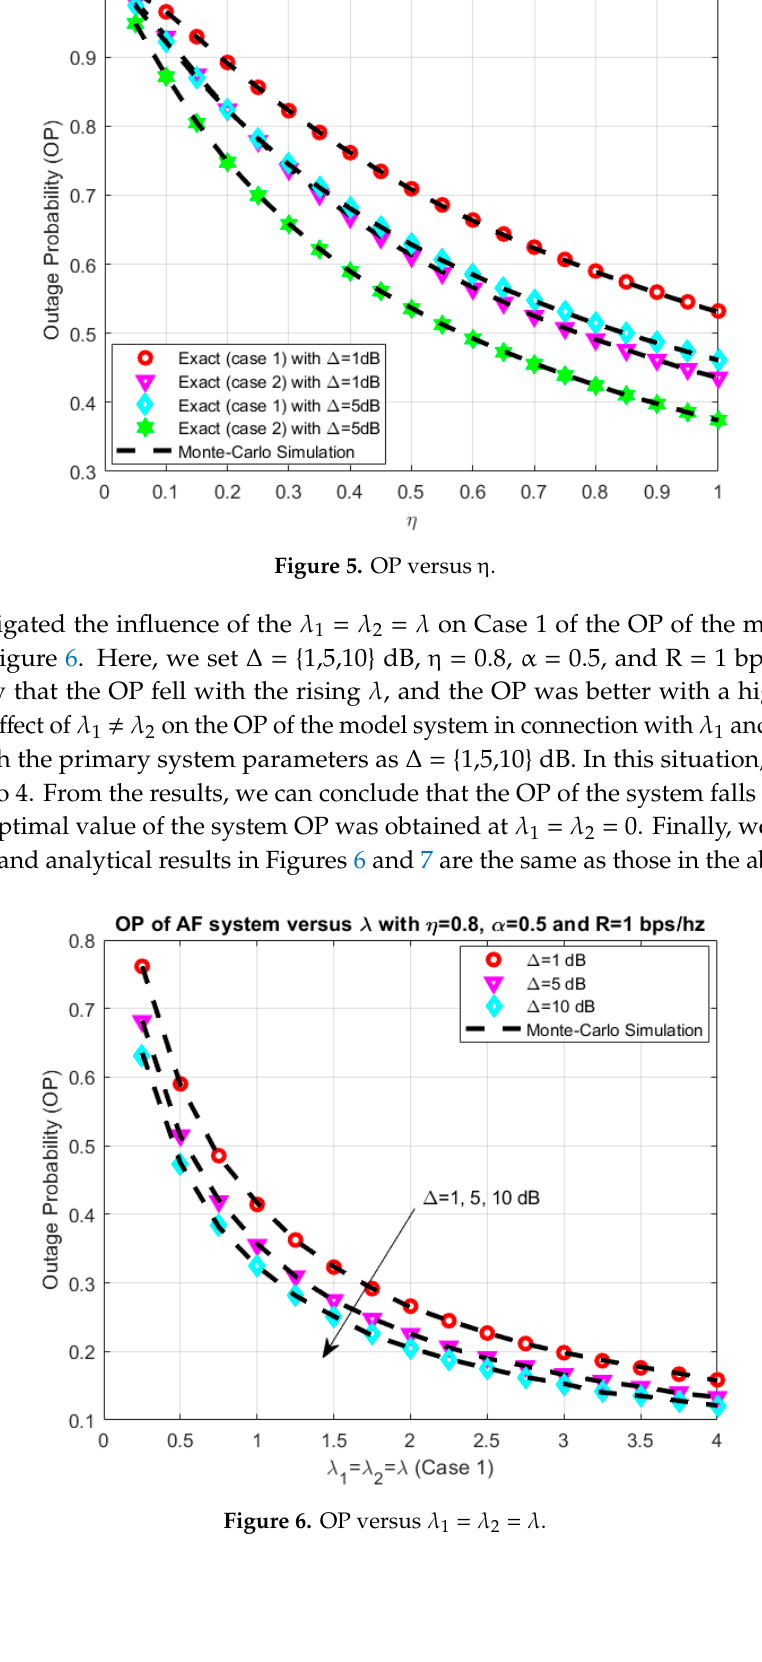
Figure 7. OP versus λ 1 ≠ λ 2 . Notably, the EE of the model system versus α is shown in Figure 8 with η = {0.5, 0.85}, R = 1 bps/Hz, Δ = 5 dB, and α varying from 0 to 1. From Figure 8, we can conclude that the EE rises significantly when α rises from 0 to 0.5, after which the EE value decreases. The optimal value of EE could be obtained with α from 0.4 to 0.6. Both Cases 1 and 2 are considered in Figure 8, and it can be observed that the EE of Case 2 is better than that of Case 1 in connection with different values of η . Furthermore, the influence of the circuit power consumption (CPC) on the system EE is presented in Figure 9 with α = {0.5, 0.85}, R = 1 bps/Hz, Δ = 5 dB. In this research, we investigated two cases, Case 1 and Case 2, to validate the exact form expression of the system EE. In Figure 9, it can be seen that the system EE of Case 2 is better than that of Case 1, and the system EE significantly decreases with the increase in the CPC from 0 to 10. Also, the system EE versus Δ is plotted in Figure 10 for both